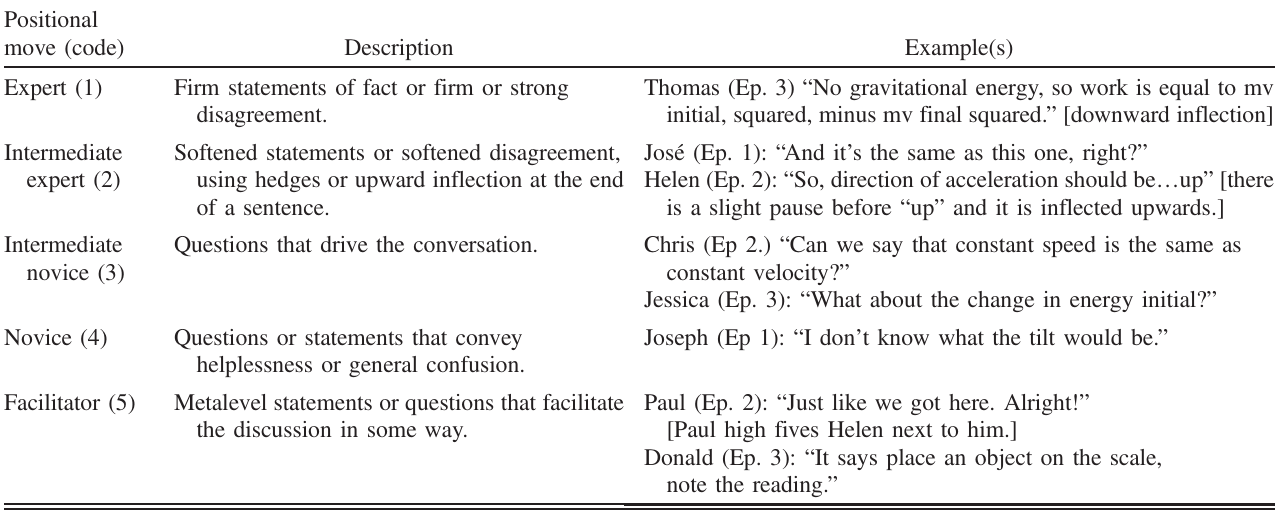
TABLE I. Table of 5 positional moves including